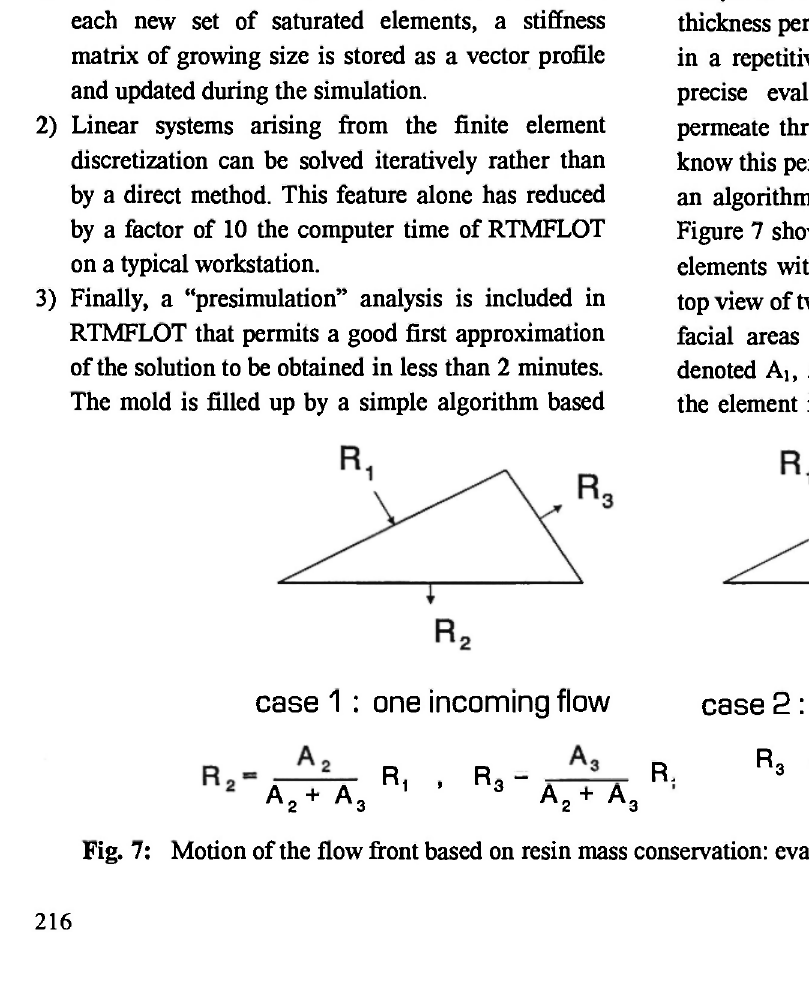
Fig. 7: Motion of the flow front based on resin mass conservation: evacuation of resin overflow in a